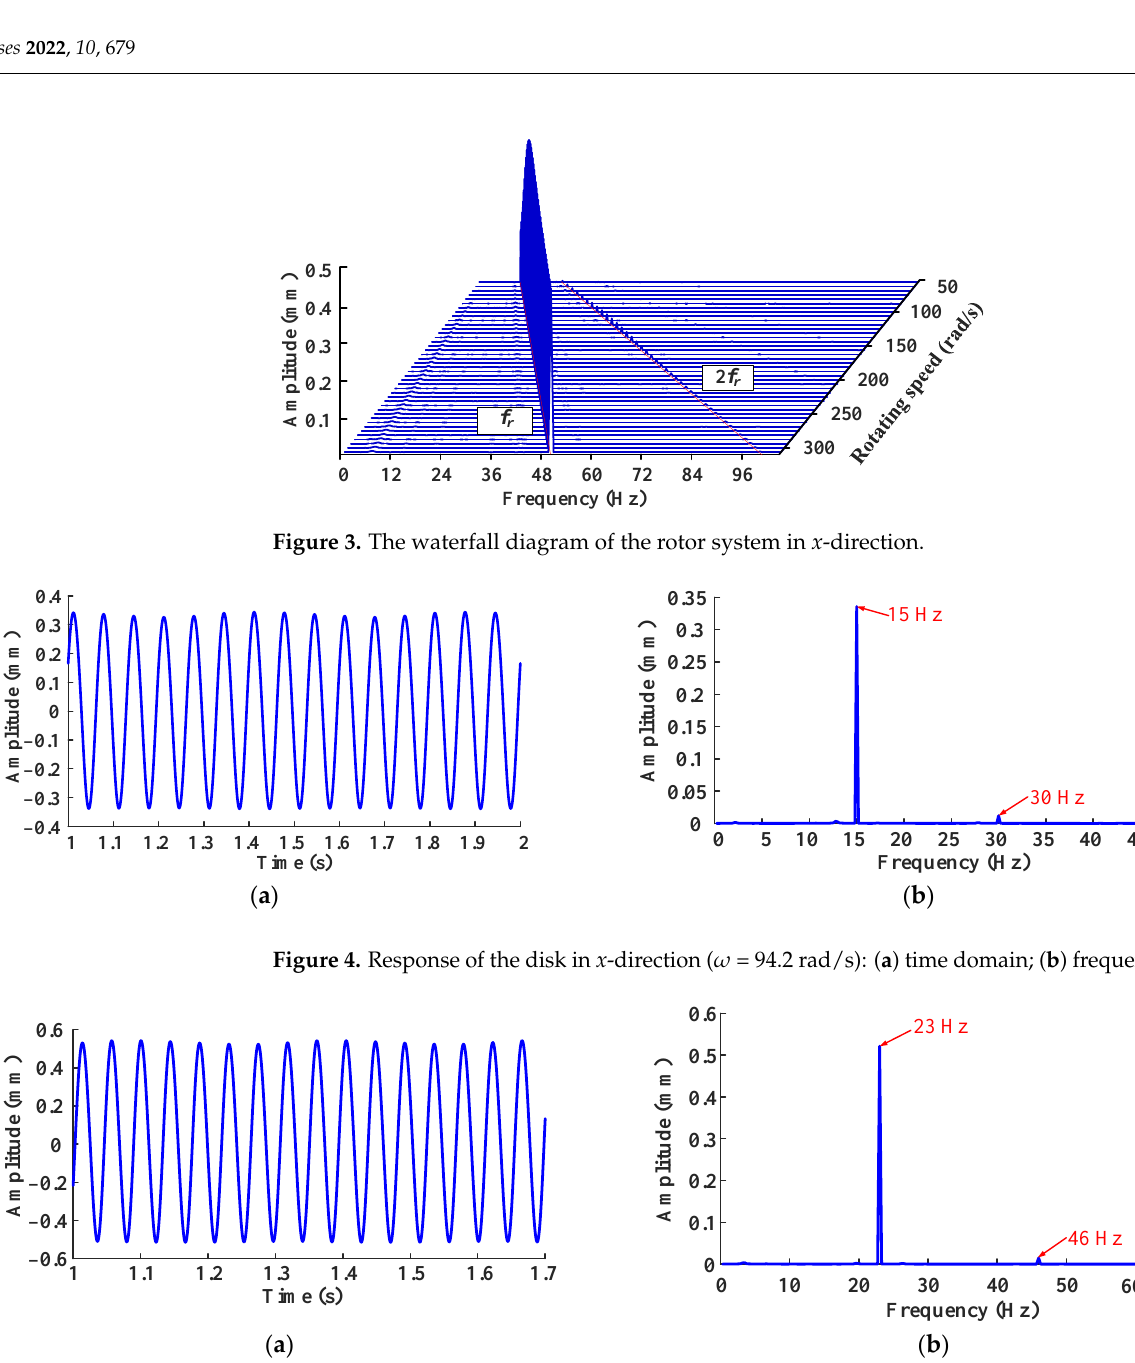
Figure 5. Response of the disk in x -direction ( ω = 144.5 rad/s): ( a ) time domain; ( b ) frequency domain.